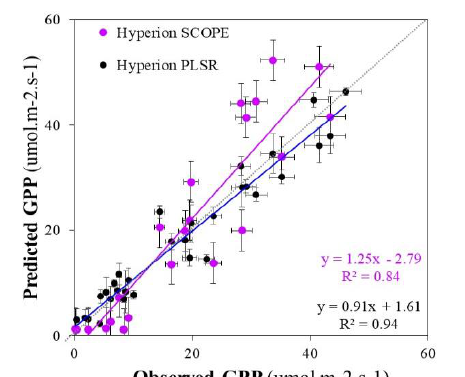
Figure 9. Comparing GPP estimates derived using Hyperion surface reflectance with empirical (i.e., PLSR, black) and radiative transfer and biophysical models (i.e., SCOPE,